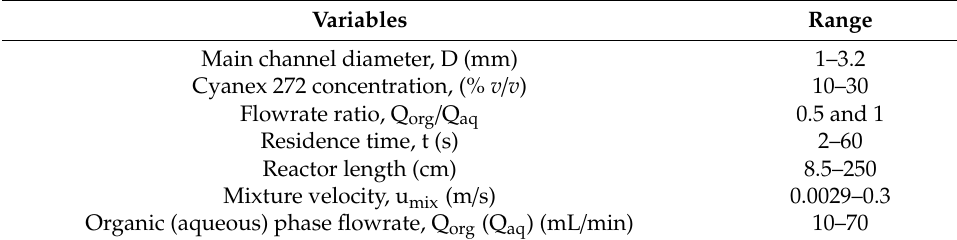
Table 3. Summary of the variables and the range